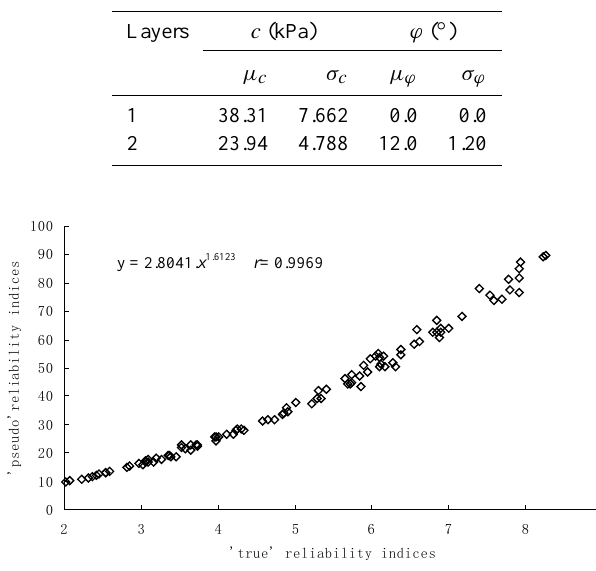
Figure 6. Relations between pseudo reliability indices and true reli- ability indices of 100 trial circular slip surfaces (normal distribution + Bishop method).